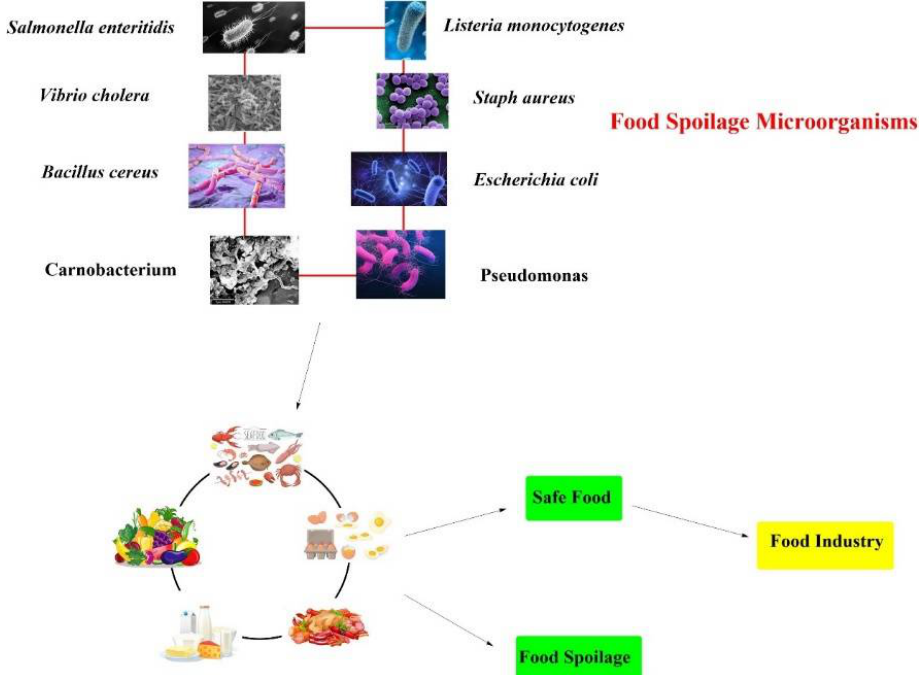
Figure 3. Main microorganisms responsible for food spoilage.